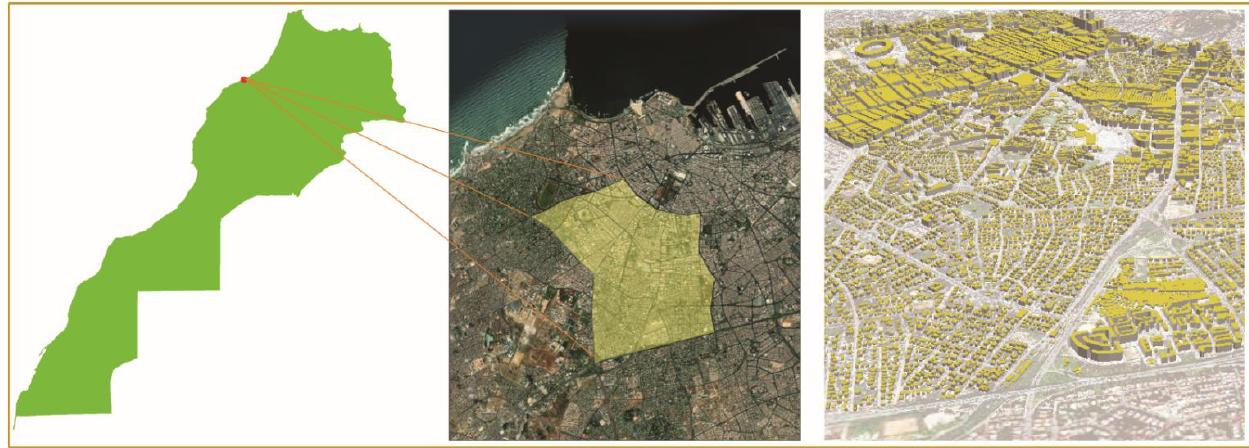
Figure 1. Geographical location of the study